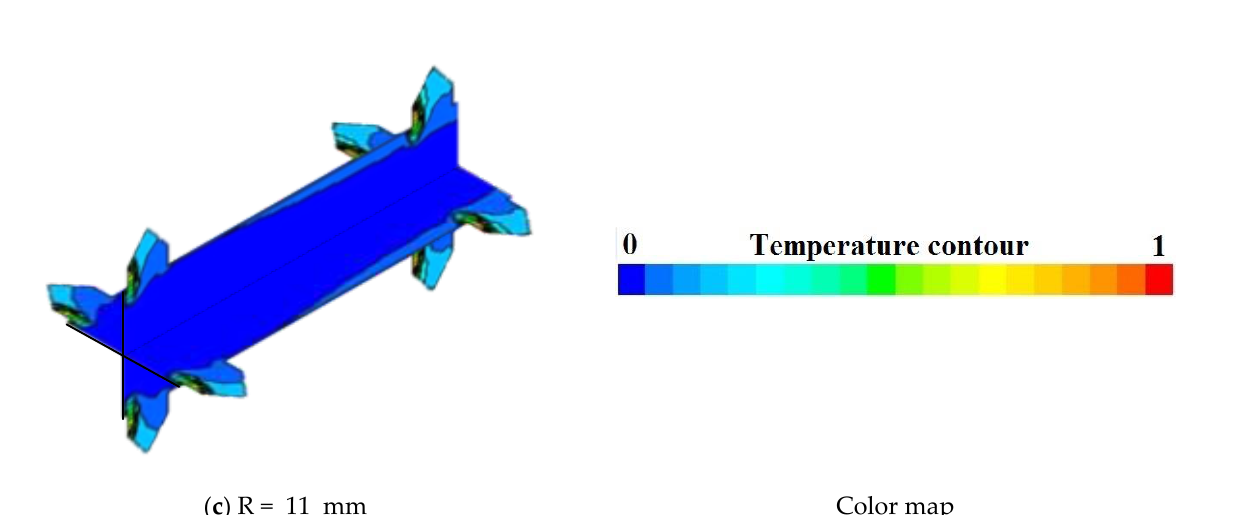
Figure 5. Temperature contours for various configurations of Case A with different R parameters at A 2 = 24 mm, Re = 15,000, and 𝜑 = 0.5%.